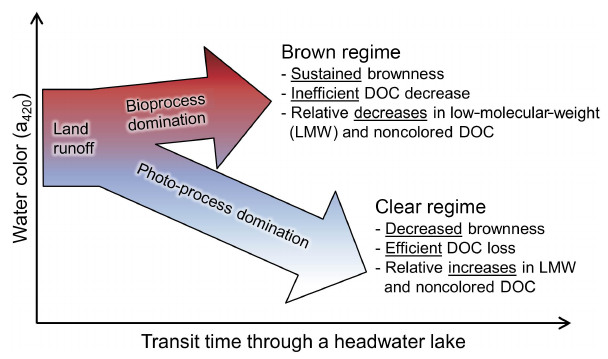
Figure 5. Conceptual representation of the trajectory of color and dissolved organic carbon (DOC) characteristics in headwater lakes with increasing residence time under brown and clear lake regimes, respectively. The figure is based on the observations from this study in which DOC processing in brown lakes is characterized by micro- bial consumption of low-molecular-weight (LMW) and noncolored DOC. Only the clear-water lakes show efficient reductions in color and DOC over time facilitated by photochemical processing that removes colored DOC to a larger extent than microbial processes. Compare with original data from Figs.